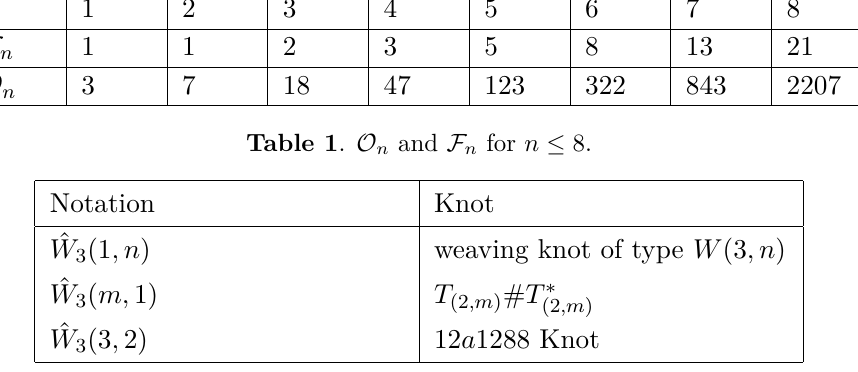
Table 2 . The classification of hybrid weaving knot ˆ W 3 ( m, n )